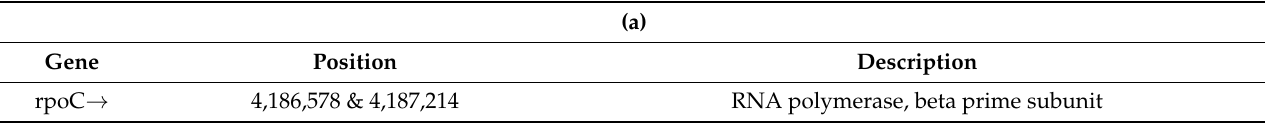
Table 4. ( a ) Position and description of selective sweeps in FeNP-resistant populations at day 25. ( b ) Position and description of significant polymorphisms in FeNP-resistant populations at day 28. ( c ) Position and description of minor polymorphisms in FeNP-resistant populations at day